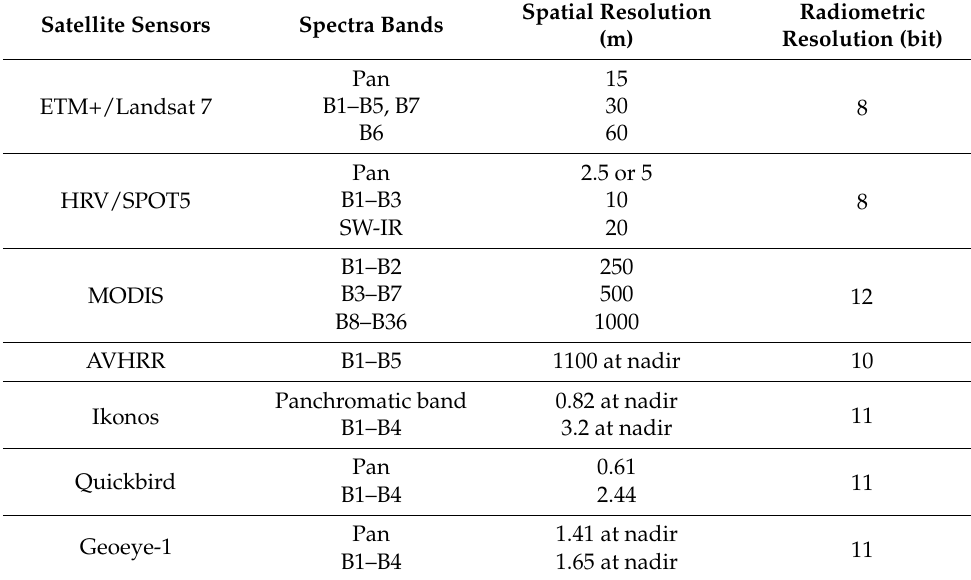
Table 2. Technical specifications of commonly known satellite sensors.